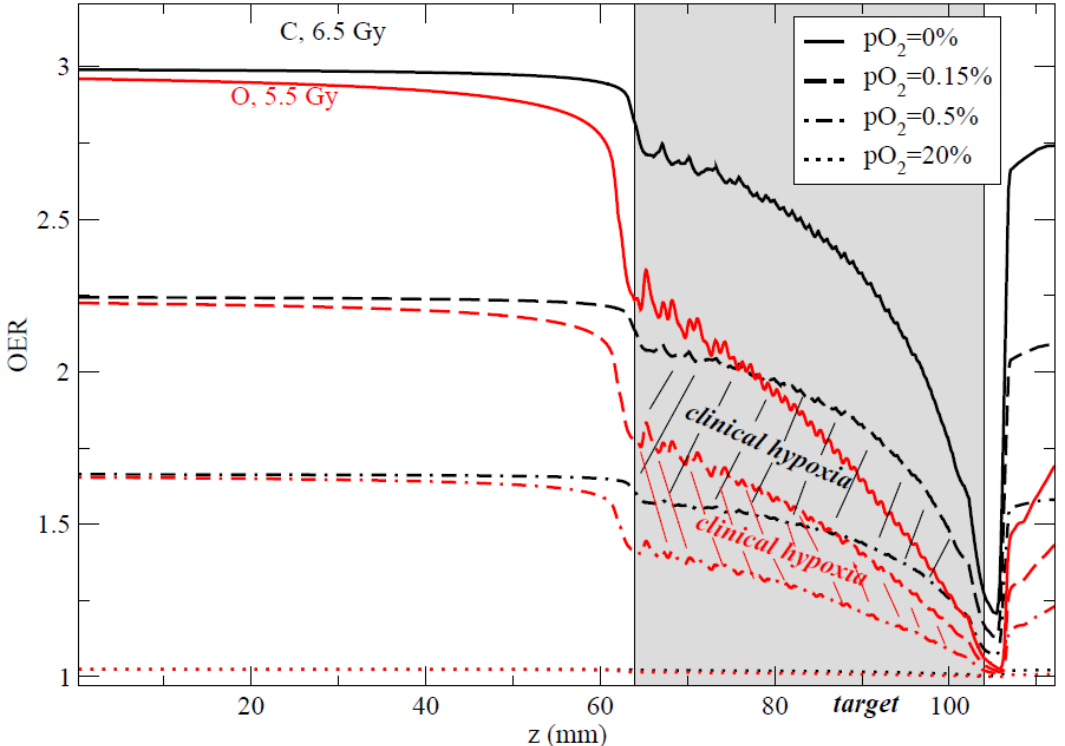
Figure 11. Comparison of the computed OER along an SOBP for carbon (black curves) and oxygen (red curves) at different pO 2 levels. The hatched areas represent the clinical interesting regions for hypoxia (0.15% < pO 2 < 0.5%). Doses indicated are prescribed RBE-weighted doses in the target to achieve iso-survival. Plans for using 16 O in the clinics are currently under way at HIT (Heidelberg). Plot from [159], © Institute of Physics and Engineering in Medicine. Reproduced by permission of IOP Publishing. All rights reserved.